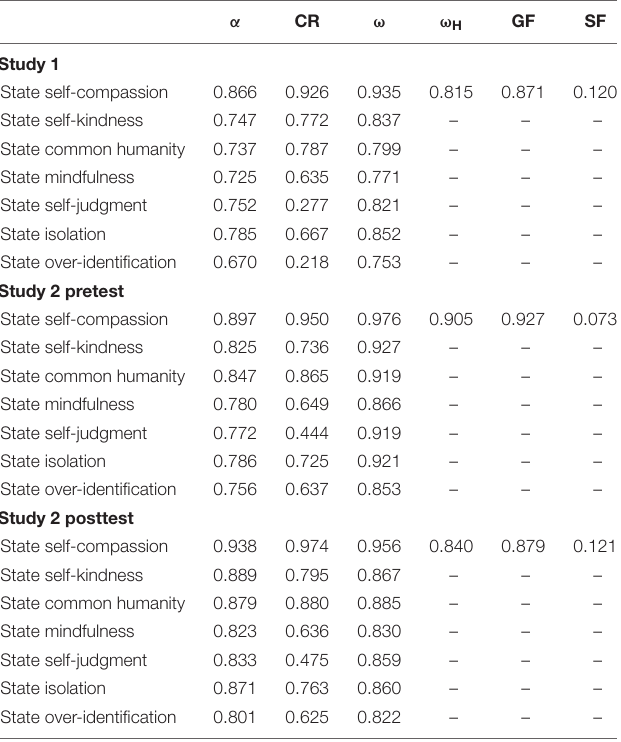
TABLE 3 | Reliabilities of the SSCS-J and reliable variance of the total score explained by the G-factor and S-factors in the bifactor ESEM solution for the SCS-J.